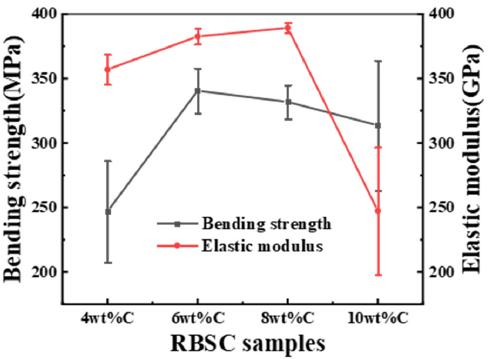
Figure 10. Flexural strength and elastic modulus as a function of RBSCs with different CB content.